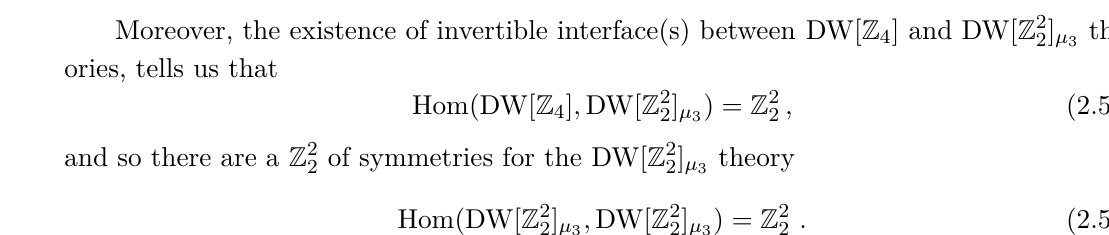
] (denoted by vertices) are dual. There is a Z 2 µ 3 2 (and edges from a vertex to itself have been 2